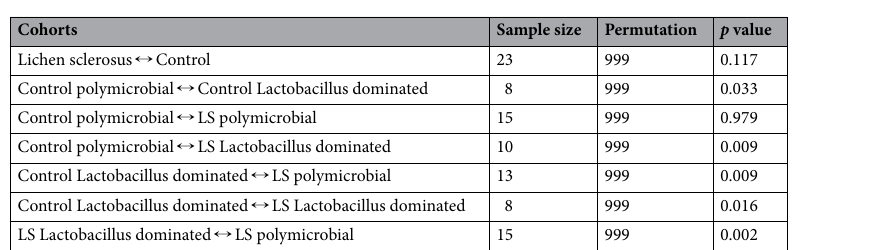
Figure 3. Polymicrobial and lactobacillus dominated clusters of LS and control samples on heatmap ( a ) and with Bray–Curtis principal coordinate analysis (PCoA) ( b ). Samples from two distinct clusters: cluster 1 contains samples with polymicrobial bacterial population; cluster 2 is dominated by members of Lactobacillus. Both clusters include LS and control patients. According to PERMANOVA analysis, significant difference among the LS and CTL group is not observed.